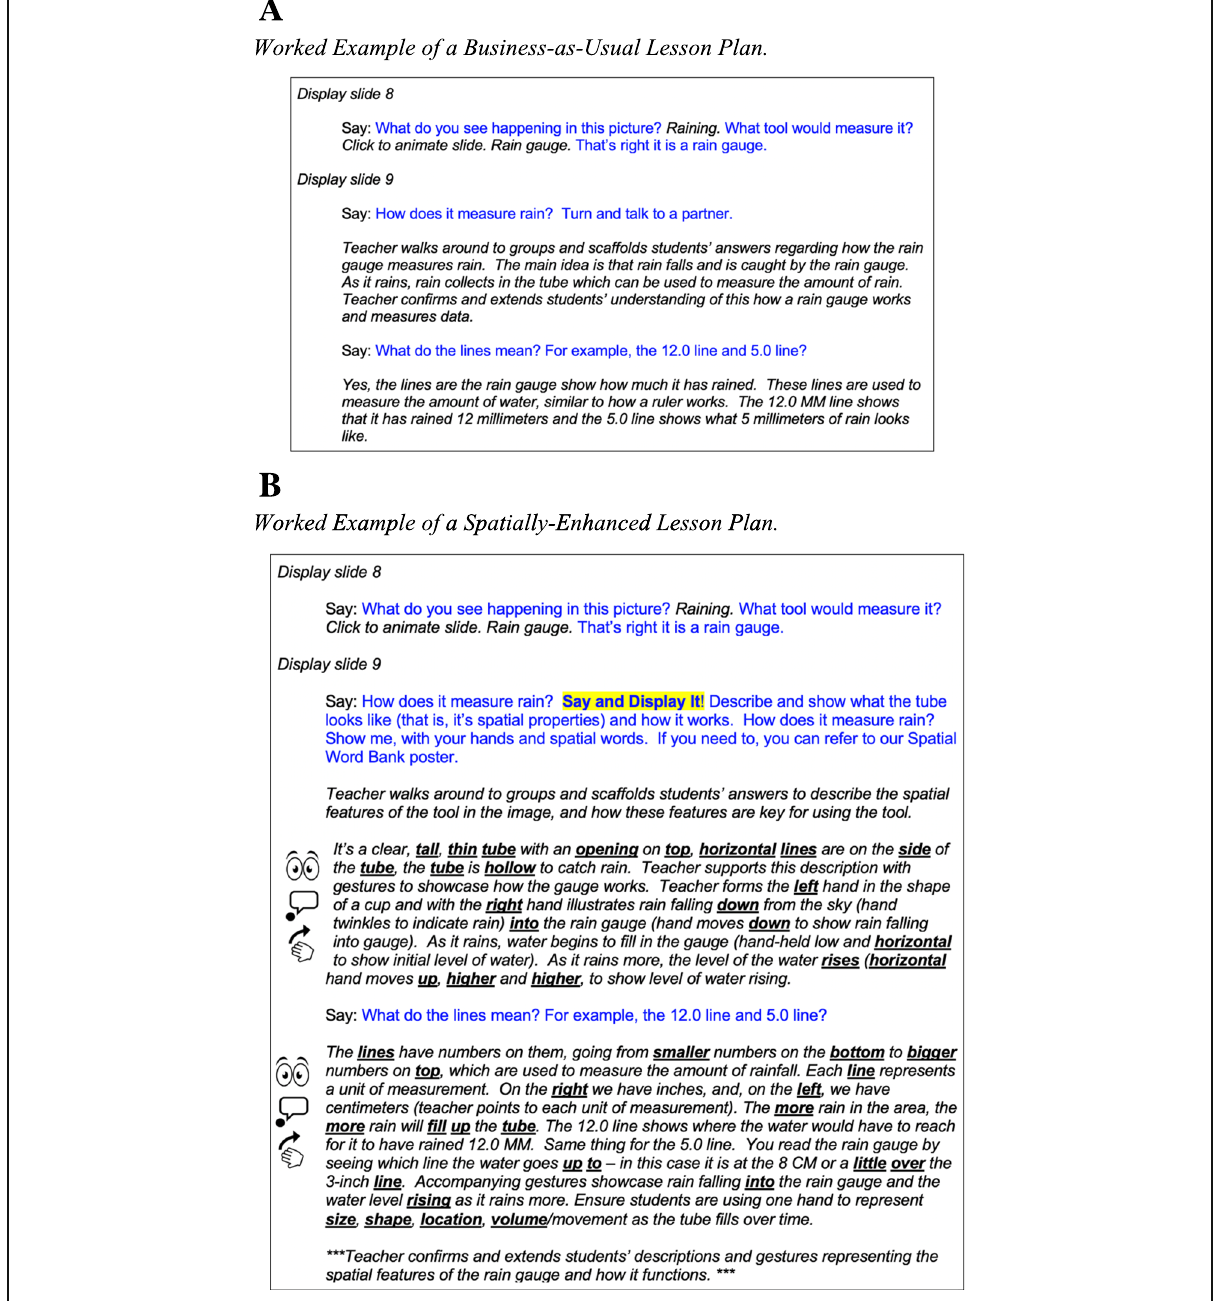
Fig. 8 a Worked example of a “ business-as-usual ” lesson plan. b Worked example of a spatially-enhanced lesson